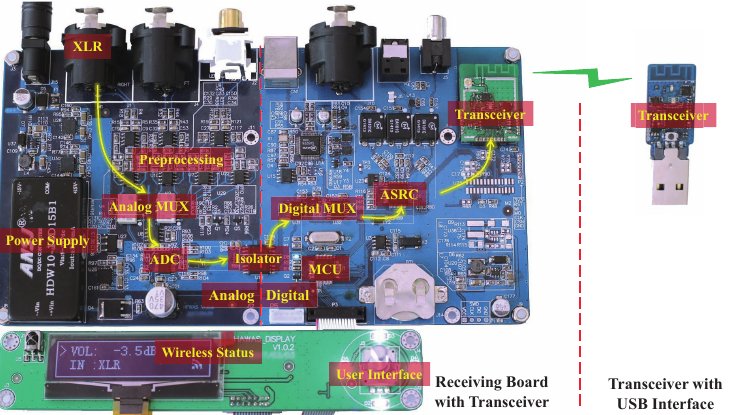
Figure A1. Wireless audio transmission system adopted in the ASR experiment.